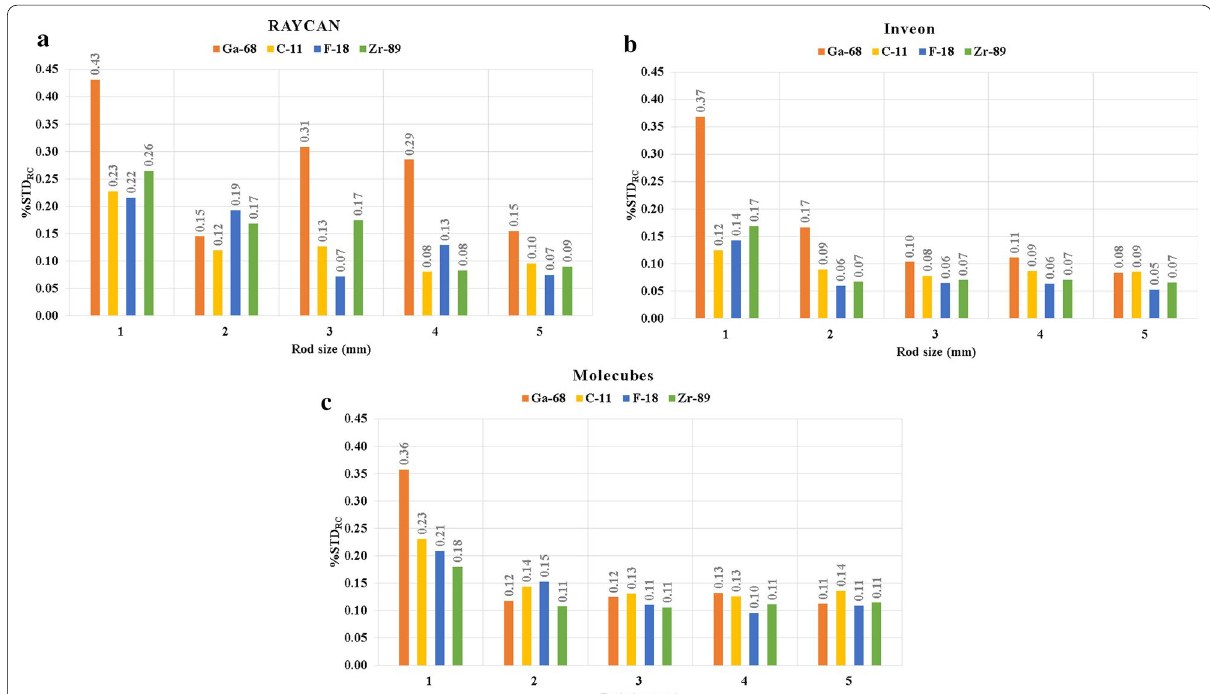
Fig. 3 Percentage standard deviation ( %STD RC ) with different rod sizes and radionuclides with the a RAYCAN, b Inveon and c Molecubes systems. Most variability in the %STD RC is seen with 68 Ga with rod size of 1 mm on the Molecubes system and with rod size of 1 mm and 2 mm on the Inveon system, reflecting system resolution. The RAYCAN system has more variability between radionuclides, where 68 Ga shows the highest variability on nearly all rod sizes